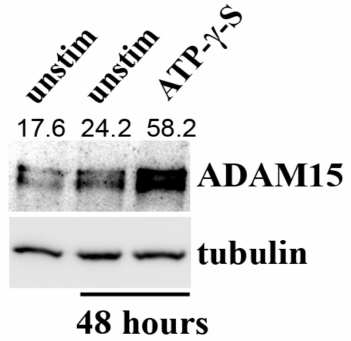
Figure A2. ATP upregulates the expression of ADAM15. Western blot analysis of ADAM15 ex- pression in RASFs stimulated with ATP- γ -S (200 µ M) for 48 h. Tubulin served as a loading control. Representative results out of three independent experiments are shown. Densitometric evaluation of protein bands, normalized to tubulin, are shown as numbers above the gel